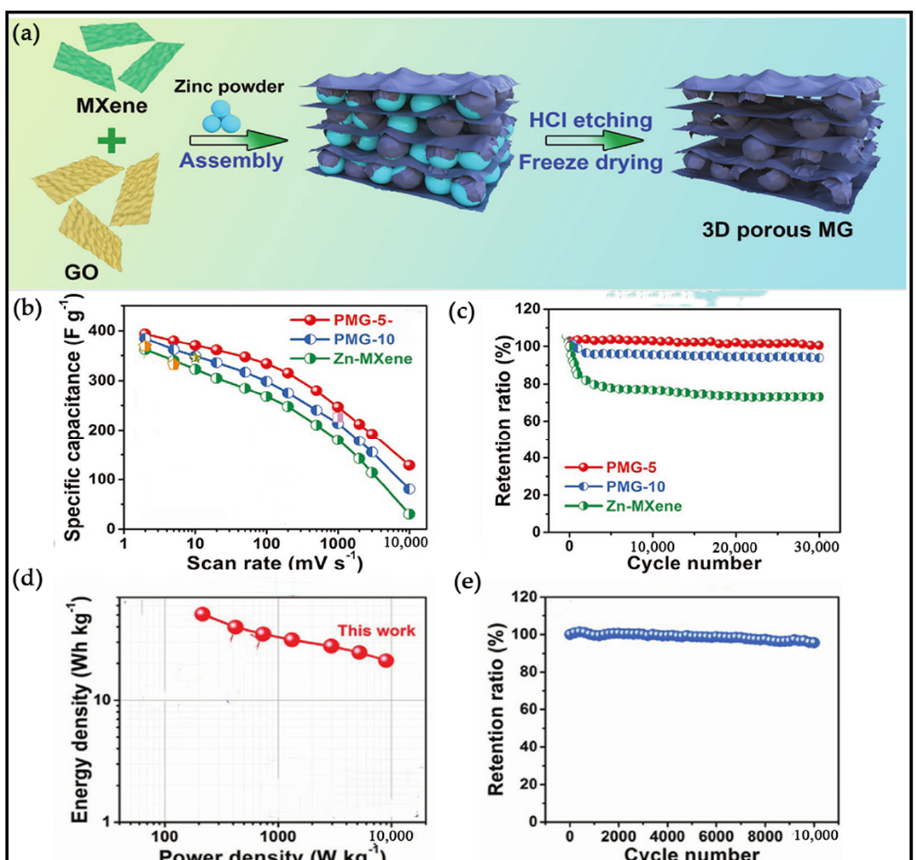
Figure 8. ( a ) Schematic illustration of the synthesis of 3D porous MG nanocomposite. ( b ) Specific capacitance at different scan rates. ( c ) Cycling stability of the Zn − MXene, PMG − 5, and PMG − 10 electrode measured at 200 mV s − 1 . ( d ) Energy and power density for PMG − 5//NHRGO ASCs. ( e ) Capacitance retention ratio of ASC at a scan rate of 100 mV s − 1 for 10,000 cycles. Reprinted with permission from Ref. [133]. Copyright 2021 Wiley-VCH GmbH.